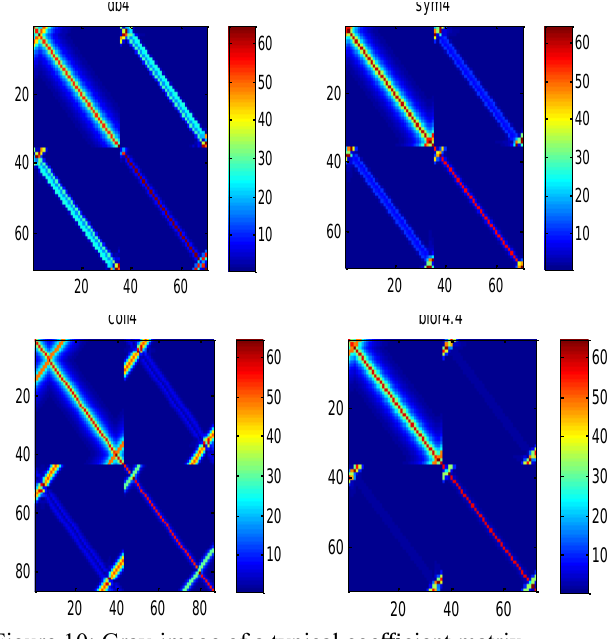
Figure 10: Gray-image of a typical coe ffi cient